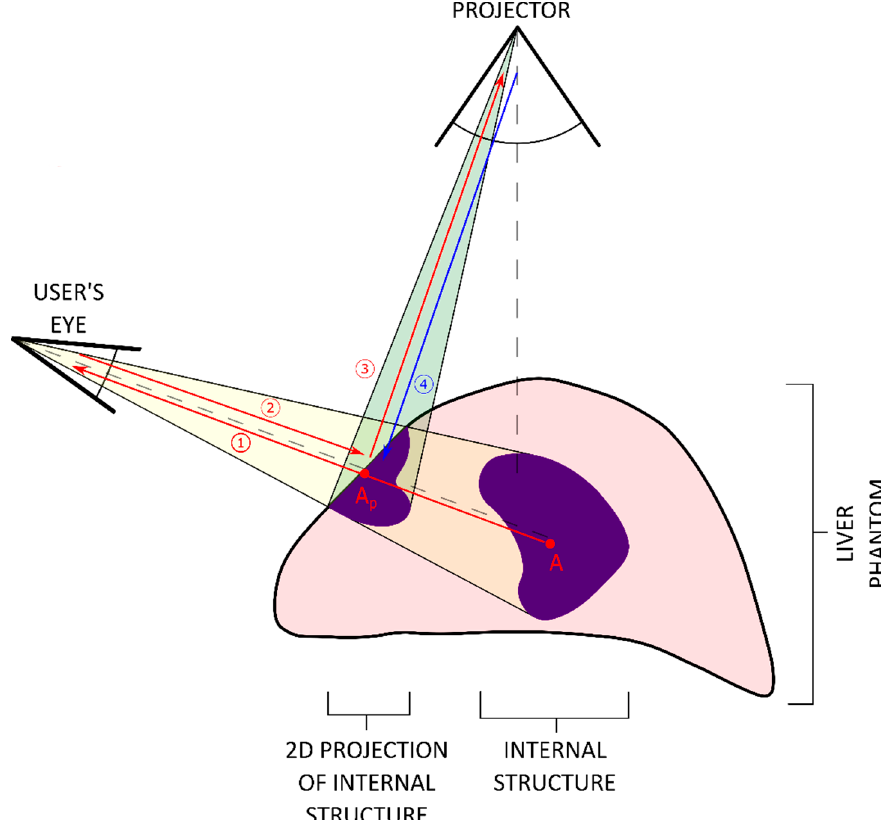
Figure 12. User’s viewpoint and projector remapping of internal structures in the liver phantom.